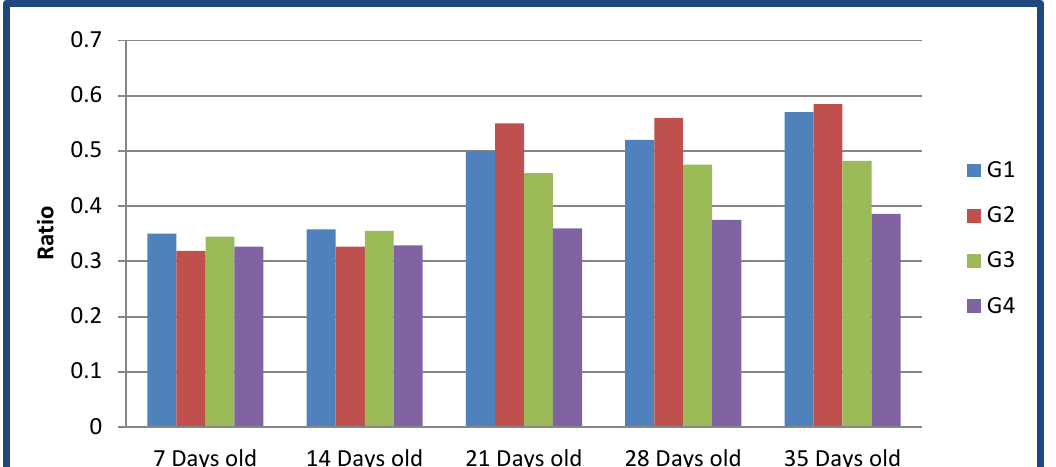
Figure,1: Effect of 225µg/ml soluble β -glucan in Heterophil/Lymphocyte ratio of heat stressed and non heat stressed groups at 7,14,21,28 and 35 days old broiler chickens. Means±SE (n=4).